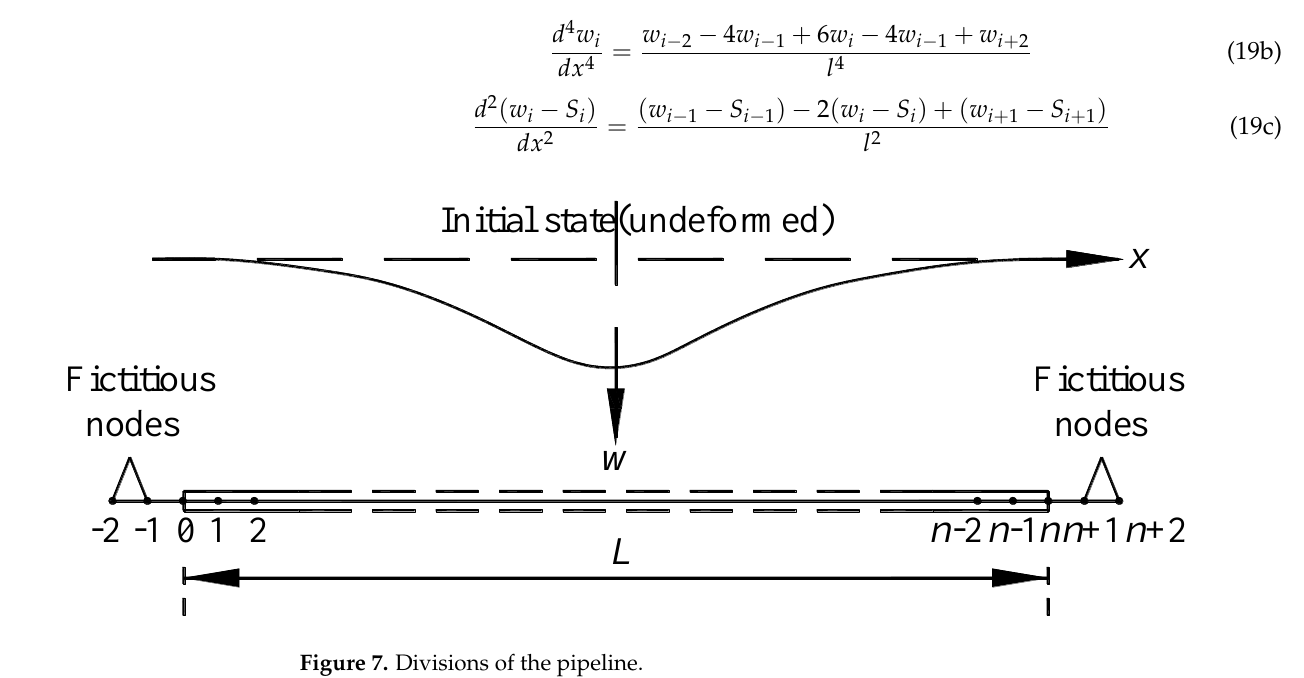
Figure 7. Divisions of the pipeline.